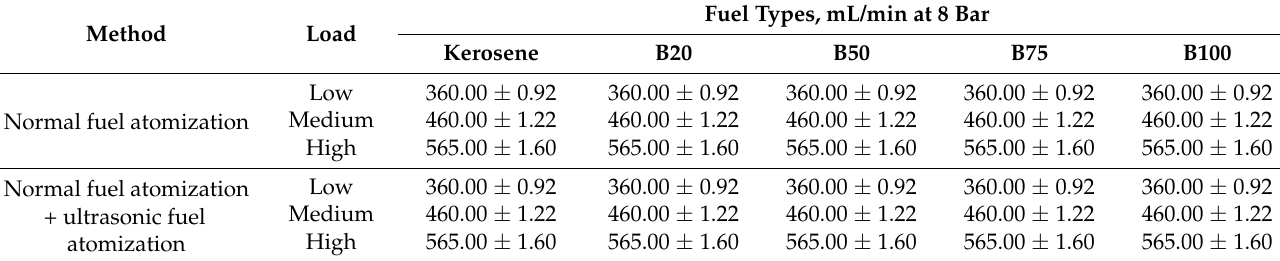
Table 4. Results of fuel flow rate against the engine load for all the different fuel types: (a) kerosene, (b) B20, (c) B50, (d) B75 and (e)